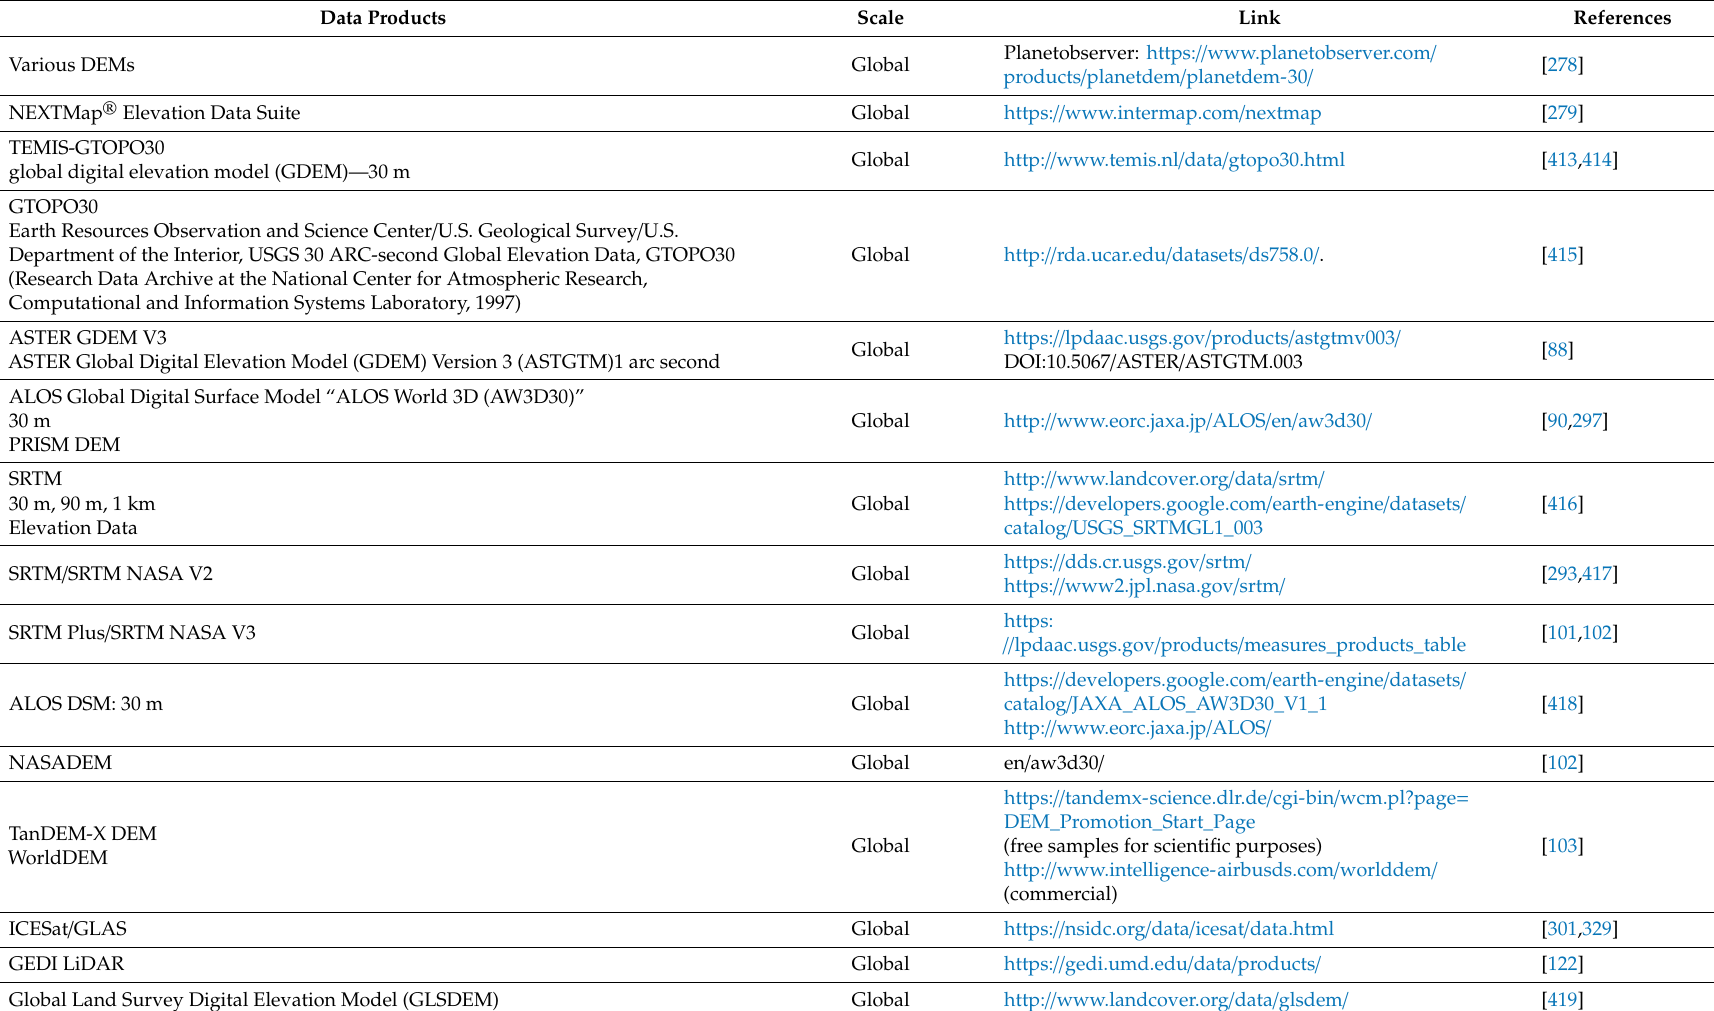
Table 7. Selection of remote sensing (RS)-aided data products for monitoring terrain, surfaces and fluvial landform data